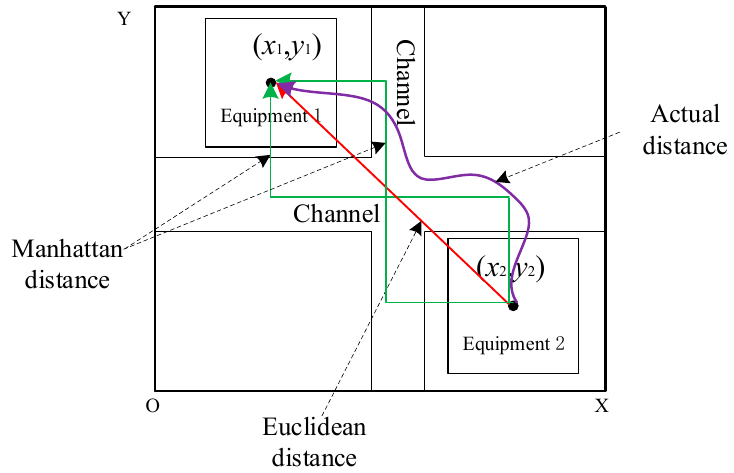
Figure 1. Manhattan distance, Euclidean distance, and Actual distance.